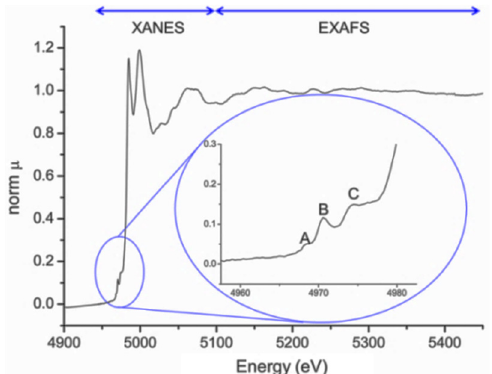
Figure 13. Normalized XAFS spectrum of the Ti K edge of the centrosymmetric perovskite LaFeNiTiO 3 , recorded at Stanford Synchrotron Radiation Lightsource. XANES and EXAFS regions are presented. The inset corresponds to the pre-edge of XANES zone. The meaning of peaks A, B, and C is given in the text.